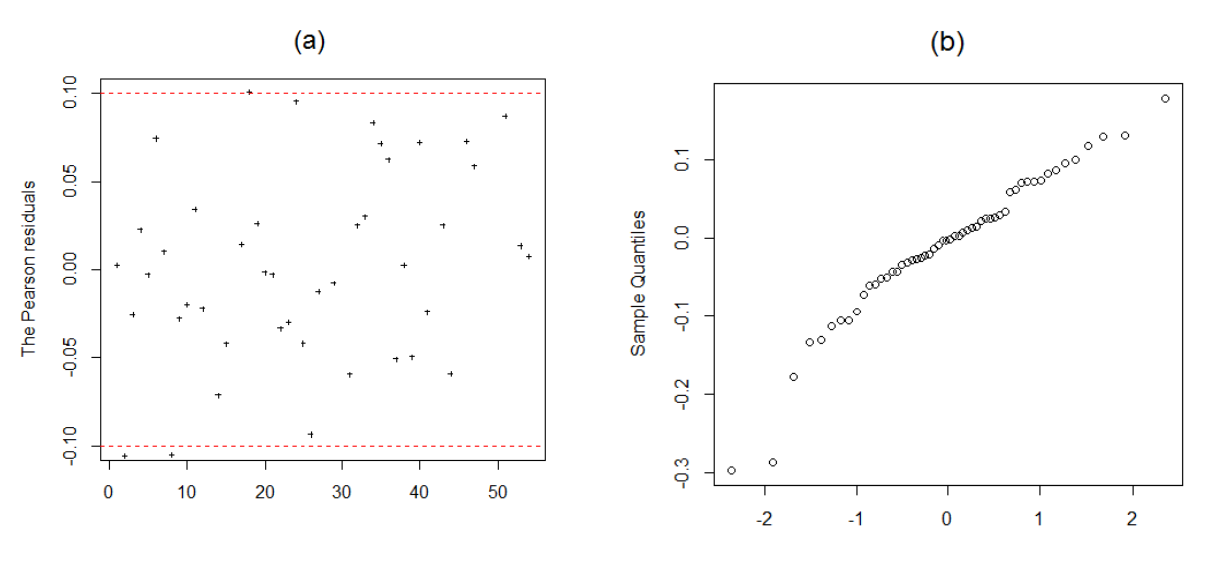
Figure 2. ( a ) Pearson residuals plot and ( b ) Normal Q-Q plot of the residuals using Model